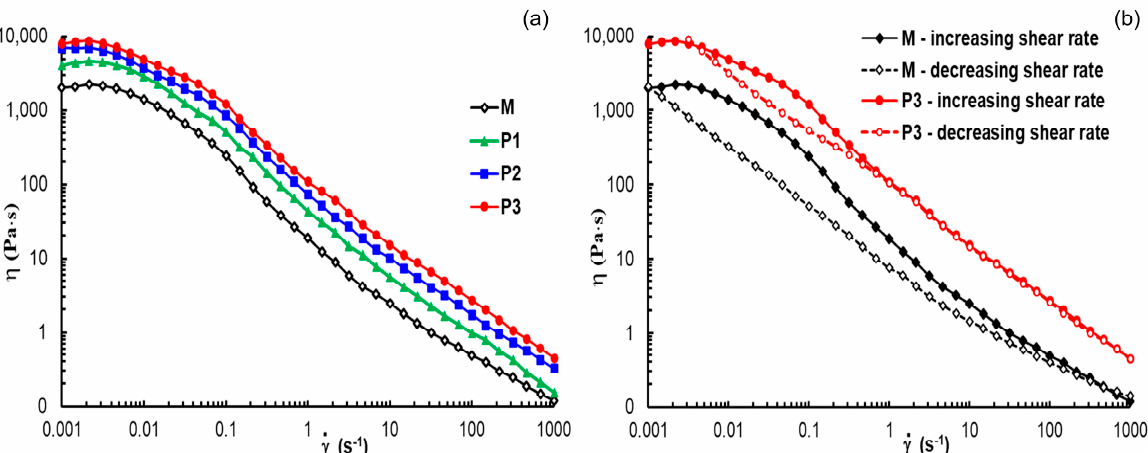
Figure 9. Plots of apparent viscosity as a function of shear rate for all investigated samples in stationary shear conditions ( a ) at increasing shear rate; ( b ) curves of apparent viscosity for samples M and P3 at increasing (full symbol) and decreasing (open symbol) shear rate.